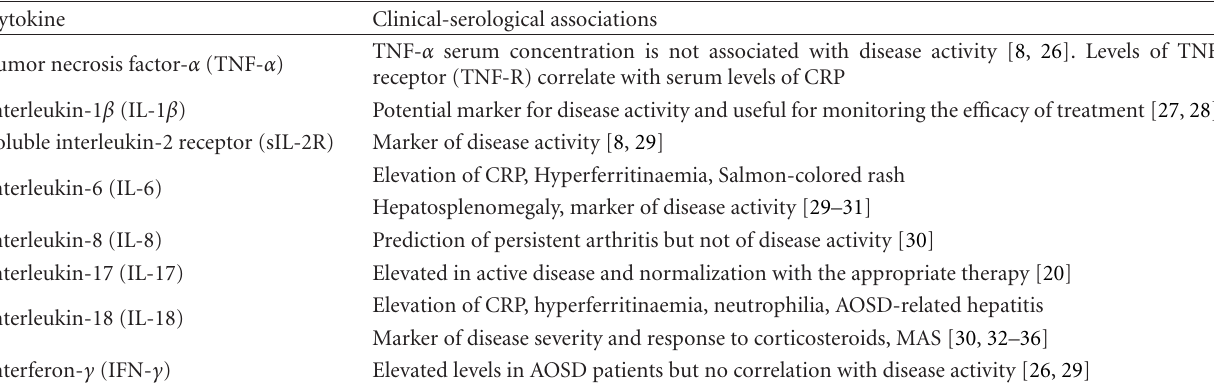
Table 1: Cytokines involved in the pathogenesis of AOSD and their potential associations with clinical/serological manifestations and disease activity. MAS: Macrophage activation syndrome, CRP: C-Reactive Protein, AOSD: Adult Onset Still’s Disease. Cytokine Clinical-serological